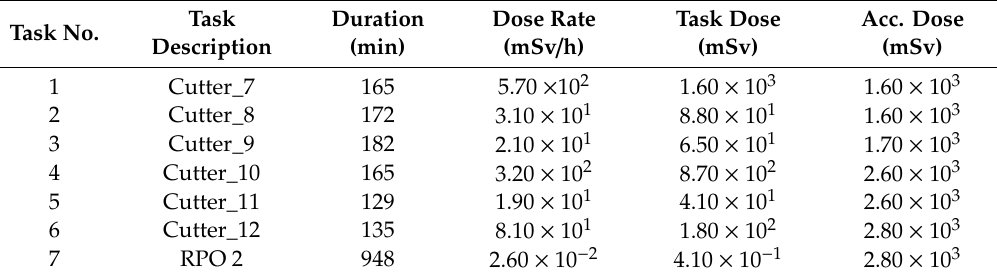
Table 6. Task information for the fragmentation of the active